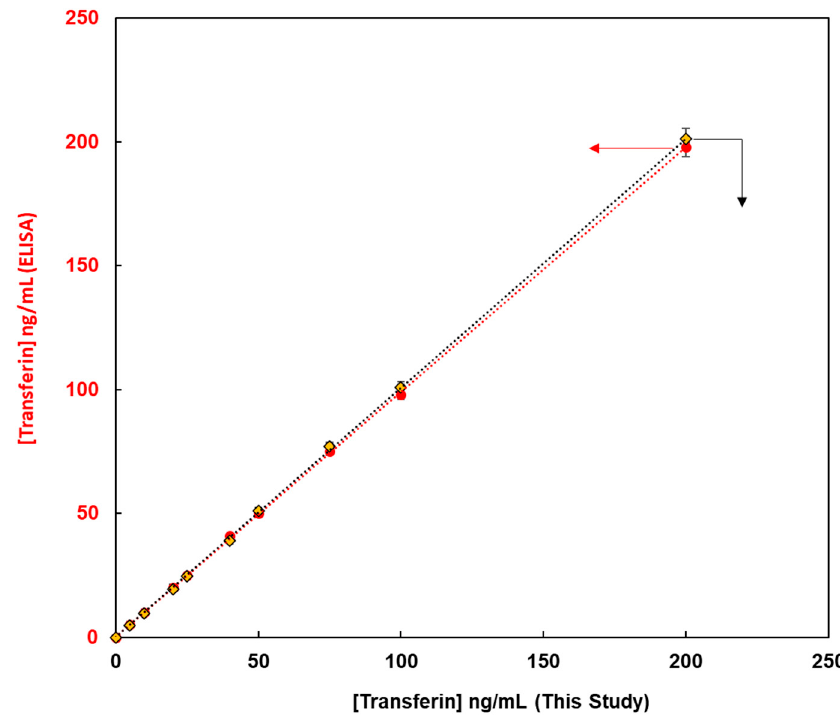
Figure 6. The relationship between transferin concentrations obtained using this method on X-axis and those obtained using ELISA on Y-axis.